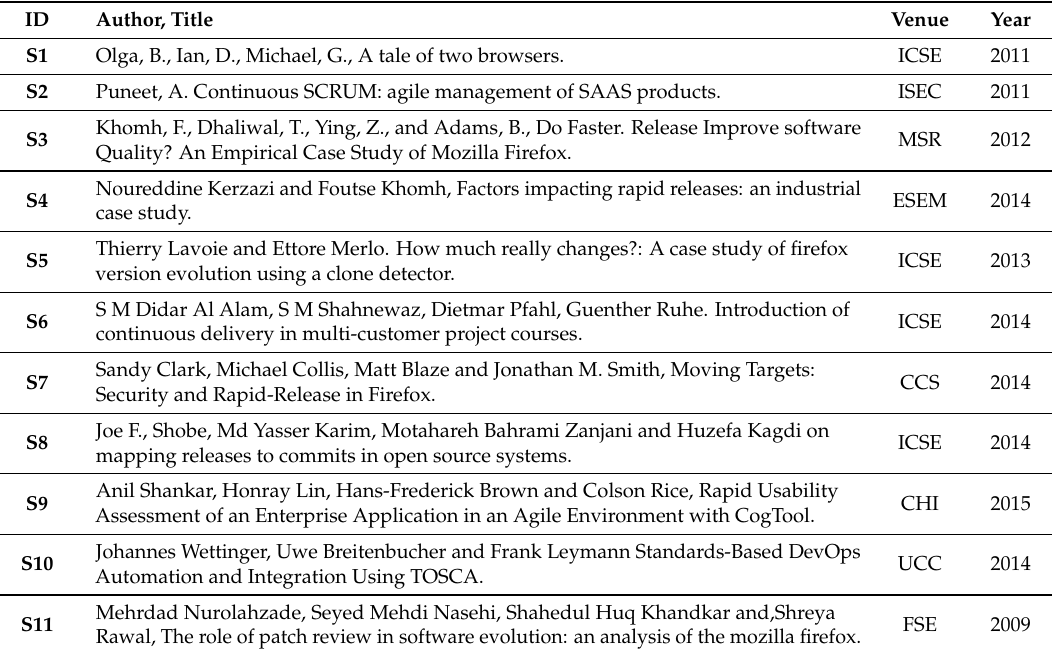
Table A1. List of selected